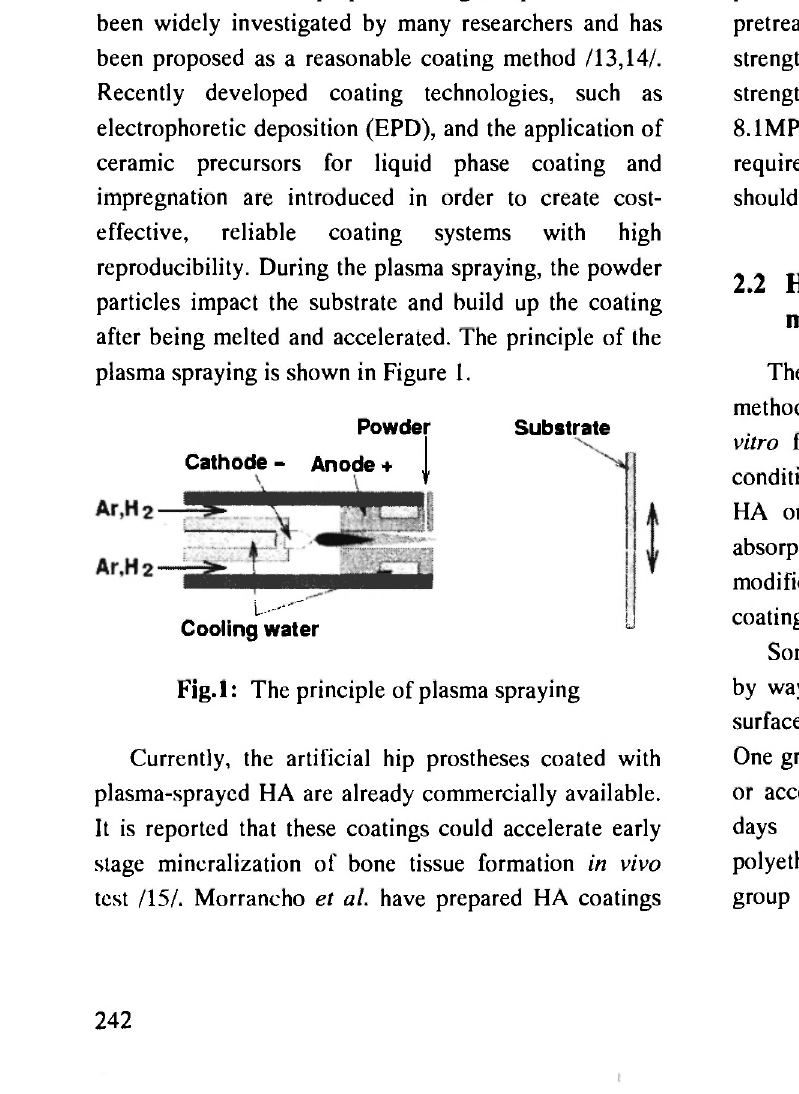
Fig.l: The principle of plasma spraying Currently, the artificial hip prostheses coated with plasma-sprayed HA are already commercially available. It is reported that these coatings could accelerate early stage mineralization of bone tissue formation in vivo test /15/. Morrancho et al. have prepared HA